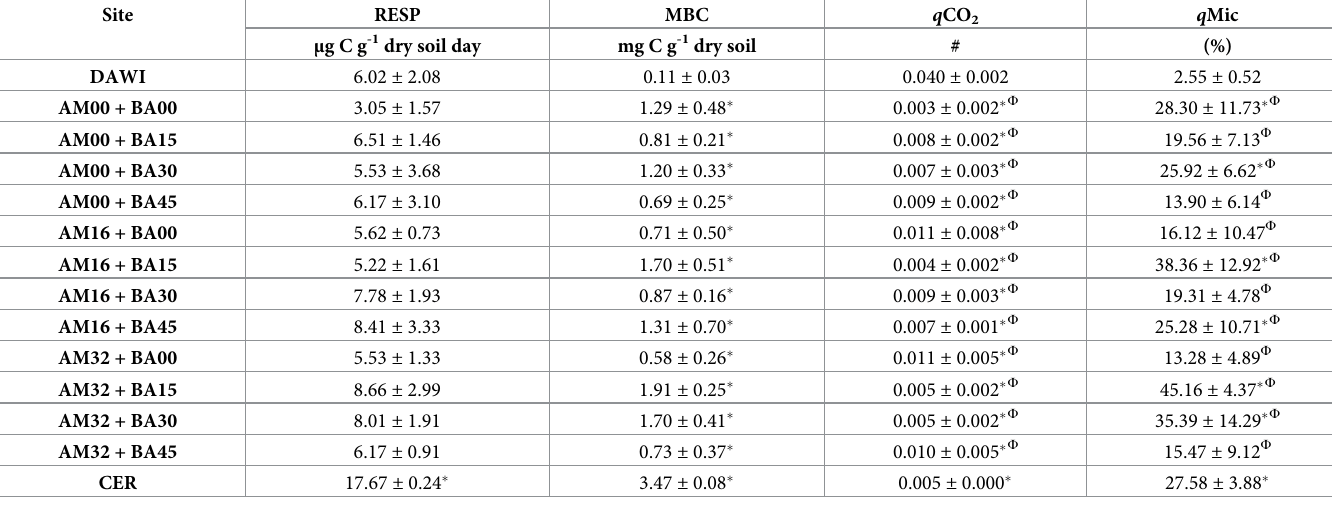
� = Mean values with asterisks are significantly different from control (DAWI) by the Dunnett test (p < 0.05). F Not significantly different than undisturbed Cerrado (CER) AM = aquatic macrophytes applied at 0, 16, and 32 t ha -1